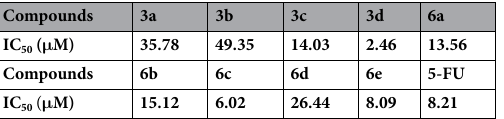
Table 1. The IC 50 values (48 h) of compounds 3a- 3d , 6a-6e and 5-FU in A549 lung cancer